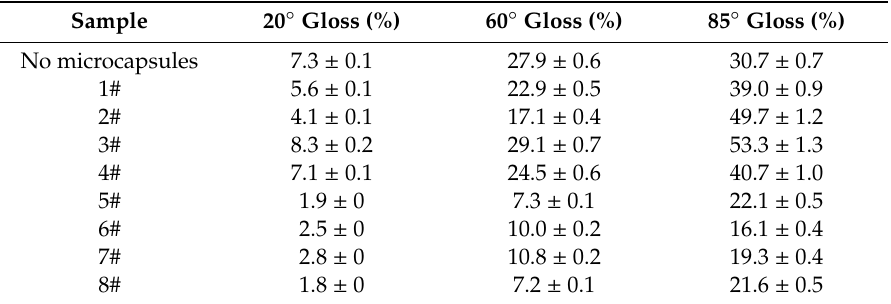
Table 4. E ff ect of the coating process on the gloss of the paint film with microcapsules.